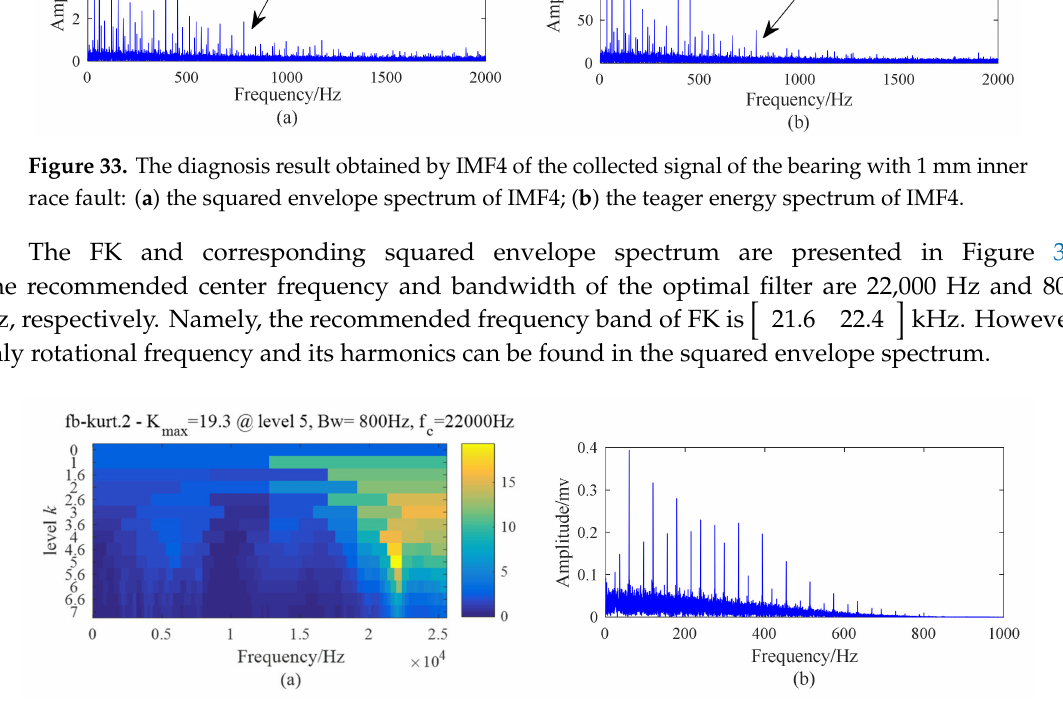
Figure 34. The diagnosis result of the collected signal of bearing with 1 mm inner race fault processed by the Fast Kurtogram (FK) method: ( a ) the kurtogram result; ( b ) the squared envelope spectrum result.